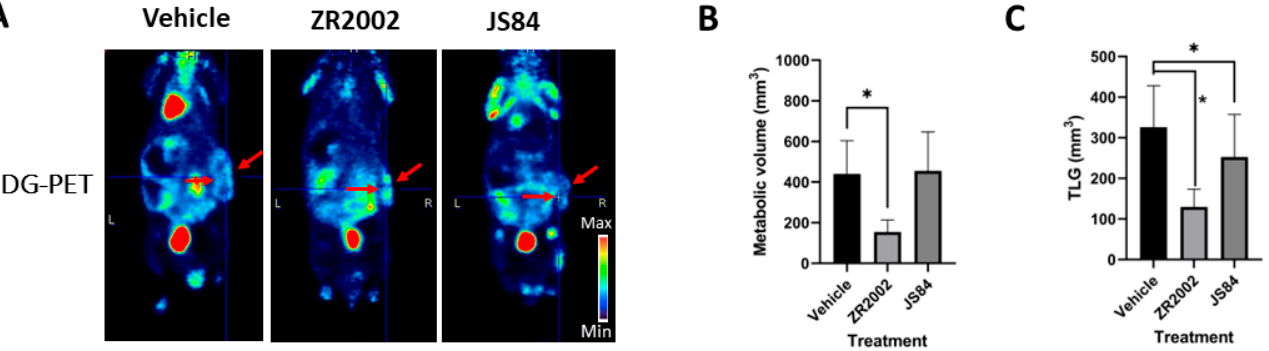
Figure 3. Tumor volume measurement with FDG-PET on day 22. FDG-PET scan was performed one day prior to the sacrifice of vehicle-, ZR2002- and JS84-treated groups. ( A ) Representative coronary sections of FDG-PET images for ZR2002-, JS84- or vehicle-treated mice (red arrows indicate the tumor) on day 22. ( B ) Metabolic volume. ( C ) Total lesion glycolysis (TLG). Data are expressed as means ± SEM. * p < 0.05 between the two